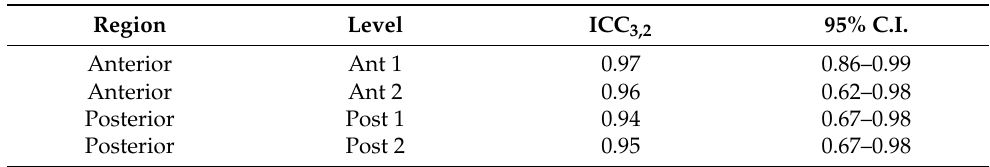
Table 5. Intra-rater reliability of the ultrasound measurements within different regions/levels of the deep fascia of the forearm between two sessions by